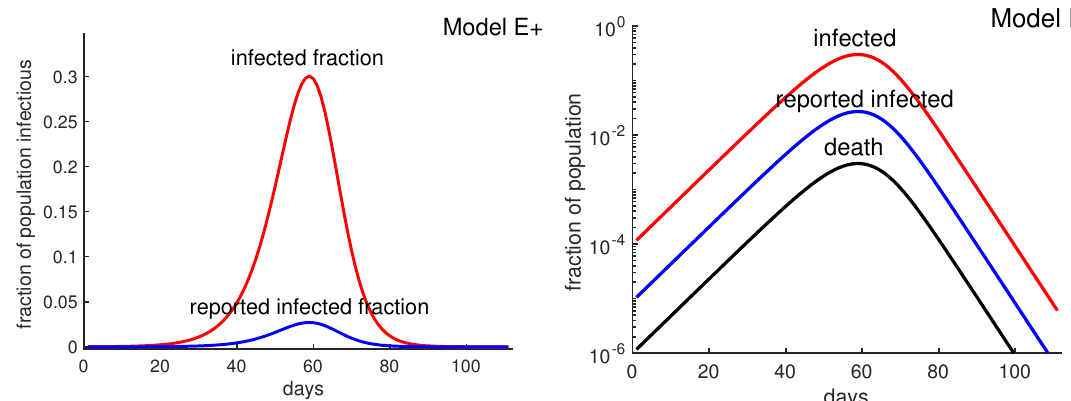
Figure 2. A1l cases vs. reported (confirmed) cases. The higher curve (red curve) represents all infectious cases as a fraction of the population for a hypothetical COVID-19 outbreak with β = 3 using Model E+. The lower curve (blue) is “reported cases” assuming 9% of cases are reported. The horizontal axis starts at week 0 when the fraction of all cases reach about 10 − 4 . The lowest curve (black curve) represents all deaths, assuming death rate is 1%. There is a time delay between being infected and being tested, having the test developed, and then posting the results. Similarly there is typically a delay between being reported and dying. These delays would shift the blue and black curves to the right. We have not shifted the curves and leave it to the reader to decide how much they should be shifted.